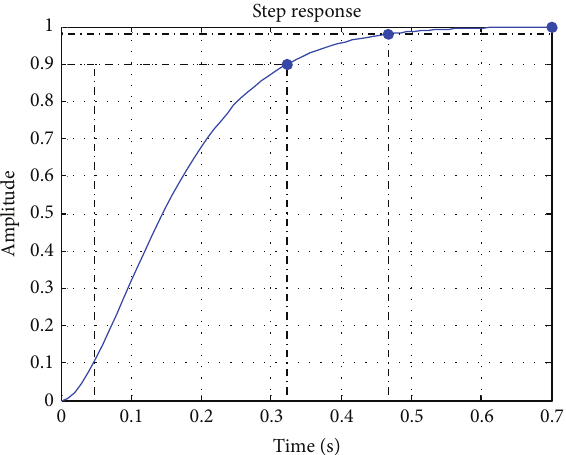
Figure 10: 𝜙 versus 𝑎 𝑦 transient response for 𝜉 = 0.95 .